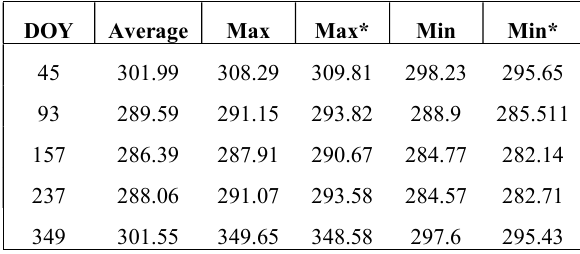
Table 3. Land Surface Temperature stats of the images, without noise and with noise (*)